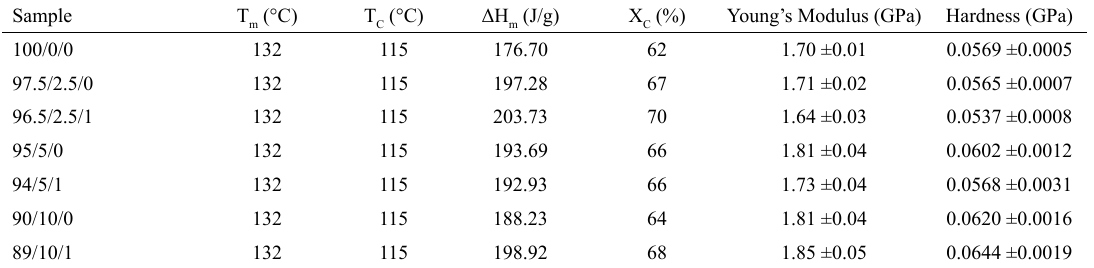
Table 4. Summary of thermal and mechanical properties for compatibilized and uncompatibilized blends. Sample